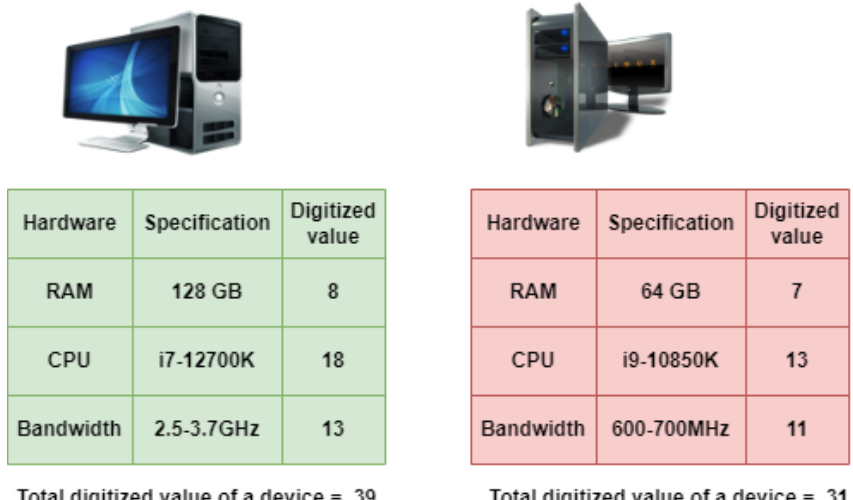
Figure 3. Example of digitization of specifications of a